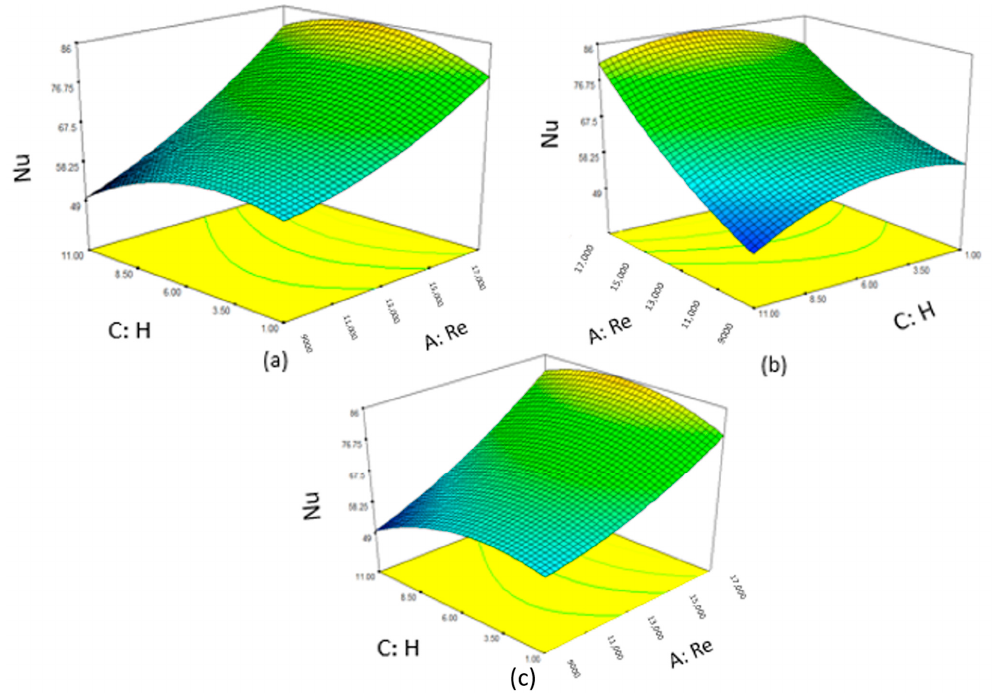
Figure 9. Nusselt number contours and 3D surface formed by the effect of Reynolds number nozzle-plate distance at the optimum conditions for the optimization target of maximum Nusselt number and nanoconcentration equal to ( a ) 0.1%; ( b ) 0.5%; ( c )